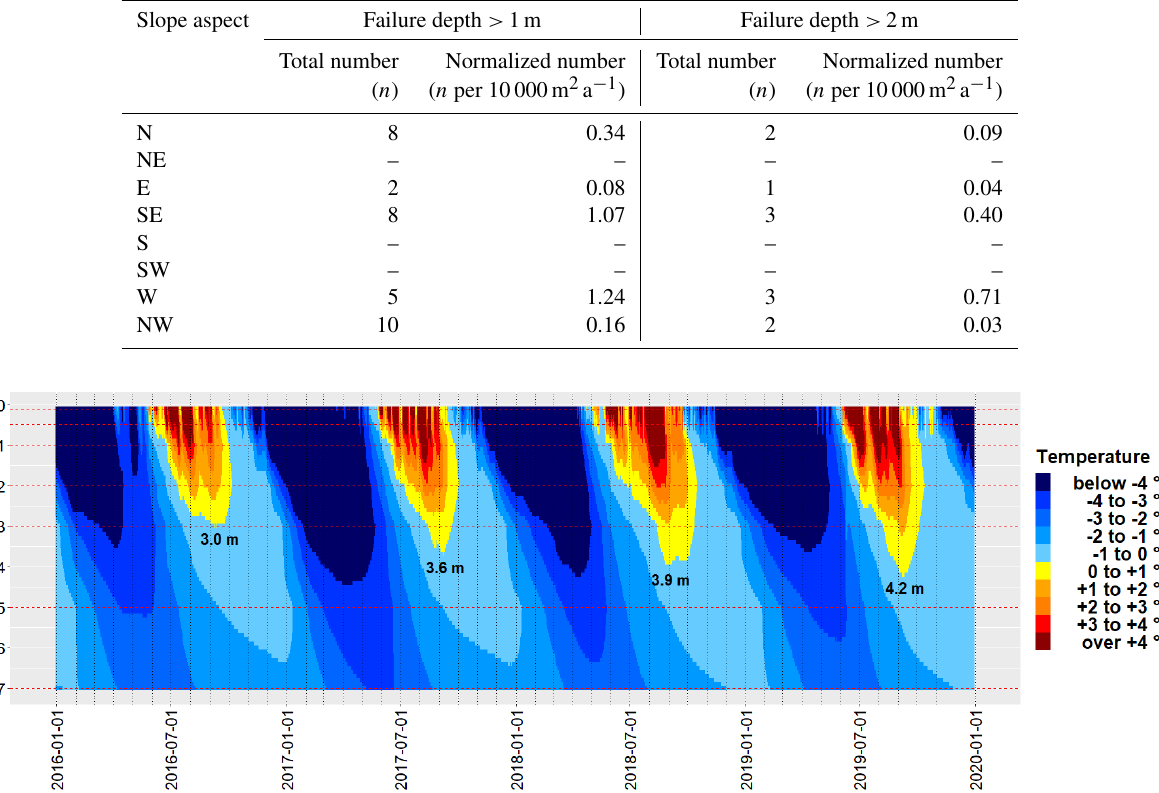
Figure 14. The 4-year borehole temperature record from 30m deep borehole T-BN (2985ma . s . l . ) located at KN (first 7m are displayed). The seasonal maximum thickness of the active layer (indicated on plot) ranged from 3.0 to